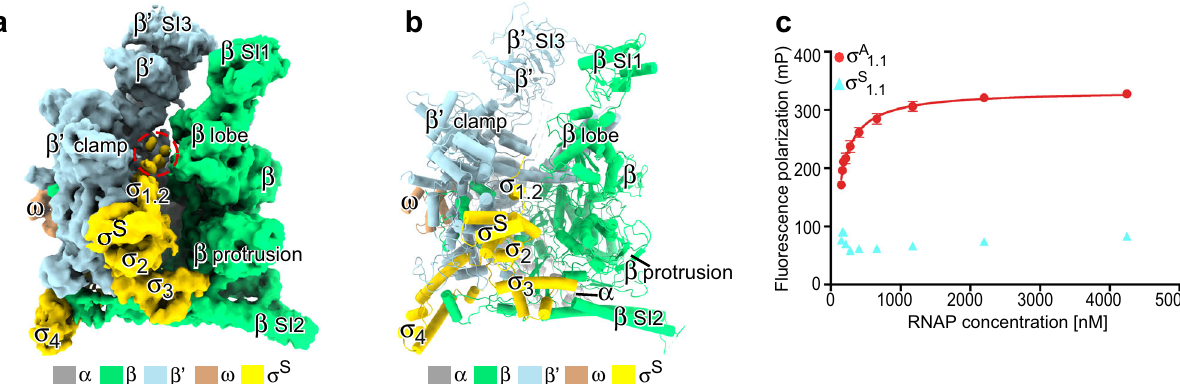
Fig. 2 The cryo-EM structure of Pae RNAP- σ S holoenzyme. a The cryo-EM map for Pae RNAP- σ S holoenzyme. RNAP subunits are colored as the color scheme. The σ S 1.1 map is circled. b The structural model for Pae RNAP- σ S holoenzyme ( σ S 1.1 is not modeled due to poor cryo-EM map signal around the region). c The results of fl uorescence anisotropy assay showed the binding of σ A 1.1 or σ S 1.1 to RNAP. The data were presented as mean±S.E.M., n = 4. Source data are provided as a Source Data fi